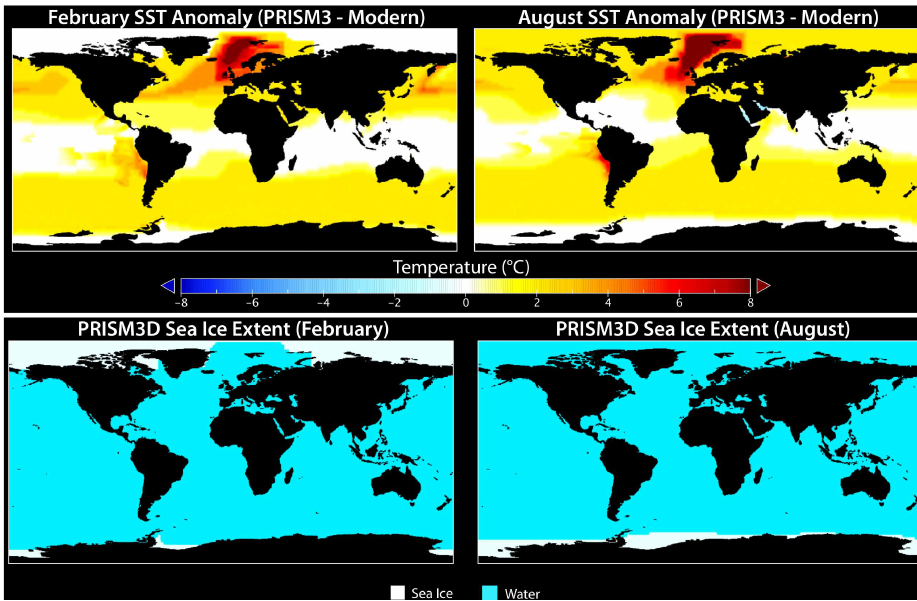
Fig. 1. PRISM3D SST anomaly for February (top left) and August (top right). PRISM3D sea-ice extent for February (bottom left) and August (bottom right).